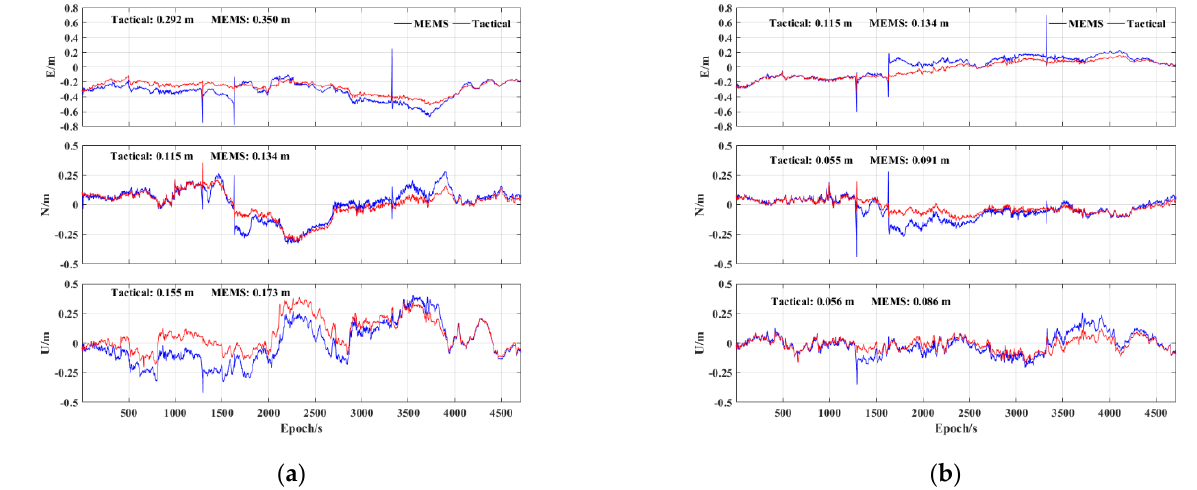
Figure 10. PPP/INS tight integration positioning error of tactical IMU and MEMS IMU: ( a ) BDS − 3 PPP − B2b RT corrections; ( b ) GFZ post − precise products.